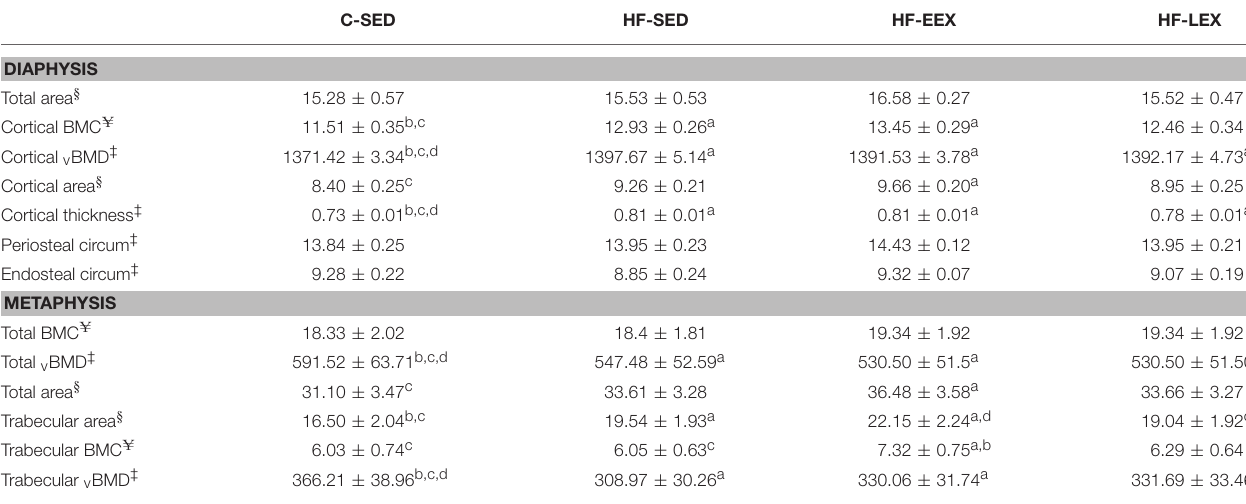
TABLE 2 | Femoral cortical and trabecular bone properties in the experimental groups at the end of the late exercise period. C-SED